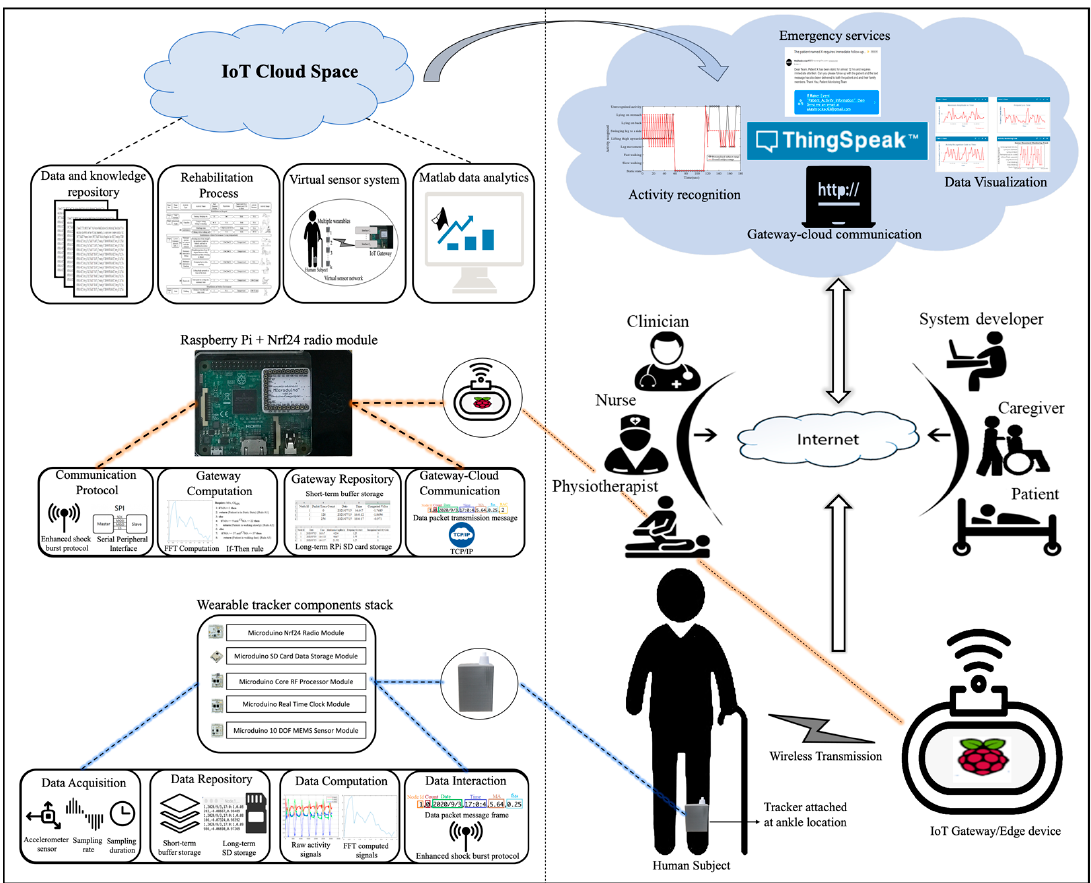
Figure 2. IoT enabled with wearables hip fracture rehabilitation movement monitoring system architectural design highlighting operational functionalities at three different levels (wireless sensing; IoT edge; and Cloud level).